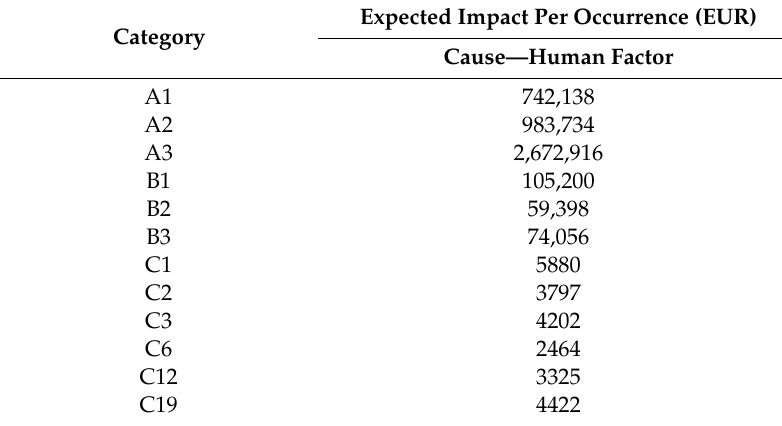
Table 3. Average total economic impacts per occurrence by